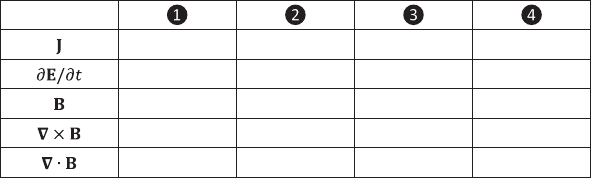
FIG. 4. Excerpt of a worksheet used in the Maxwell-Amp`ere ’ s law tutorial in differential